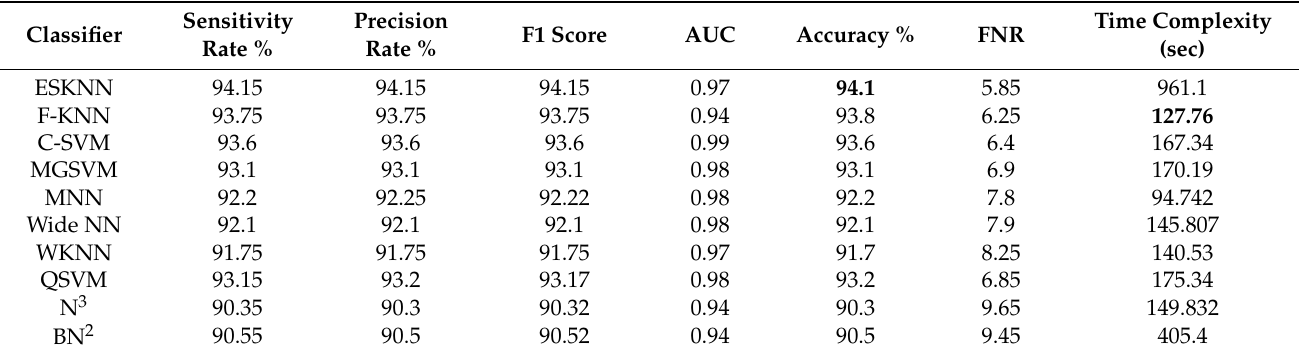
Table 4. Classification results of CBIS-DDSM using proposed feature fusion approach. The bold represent the significant value.